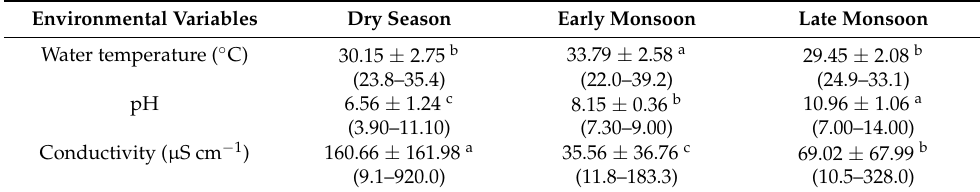
Table 3. Environmental variables (mean ± standard deviation, and range) measured at the sampling sites in Cambodia during three seasons. Values followed by the different letter(s) in the same row are significantly different ( p <